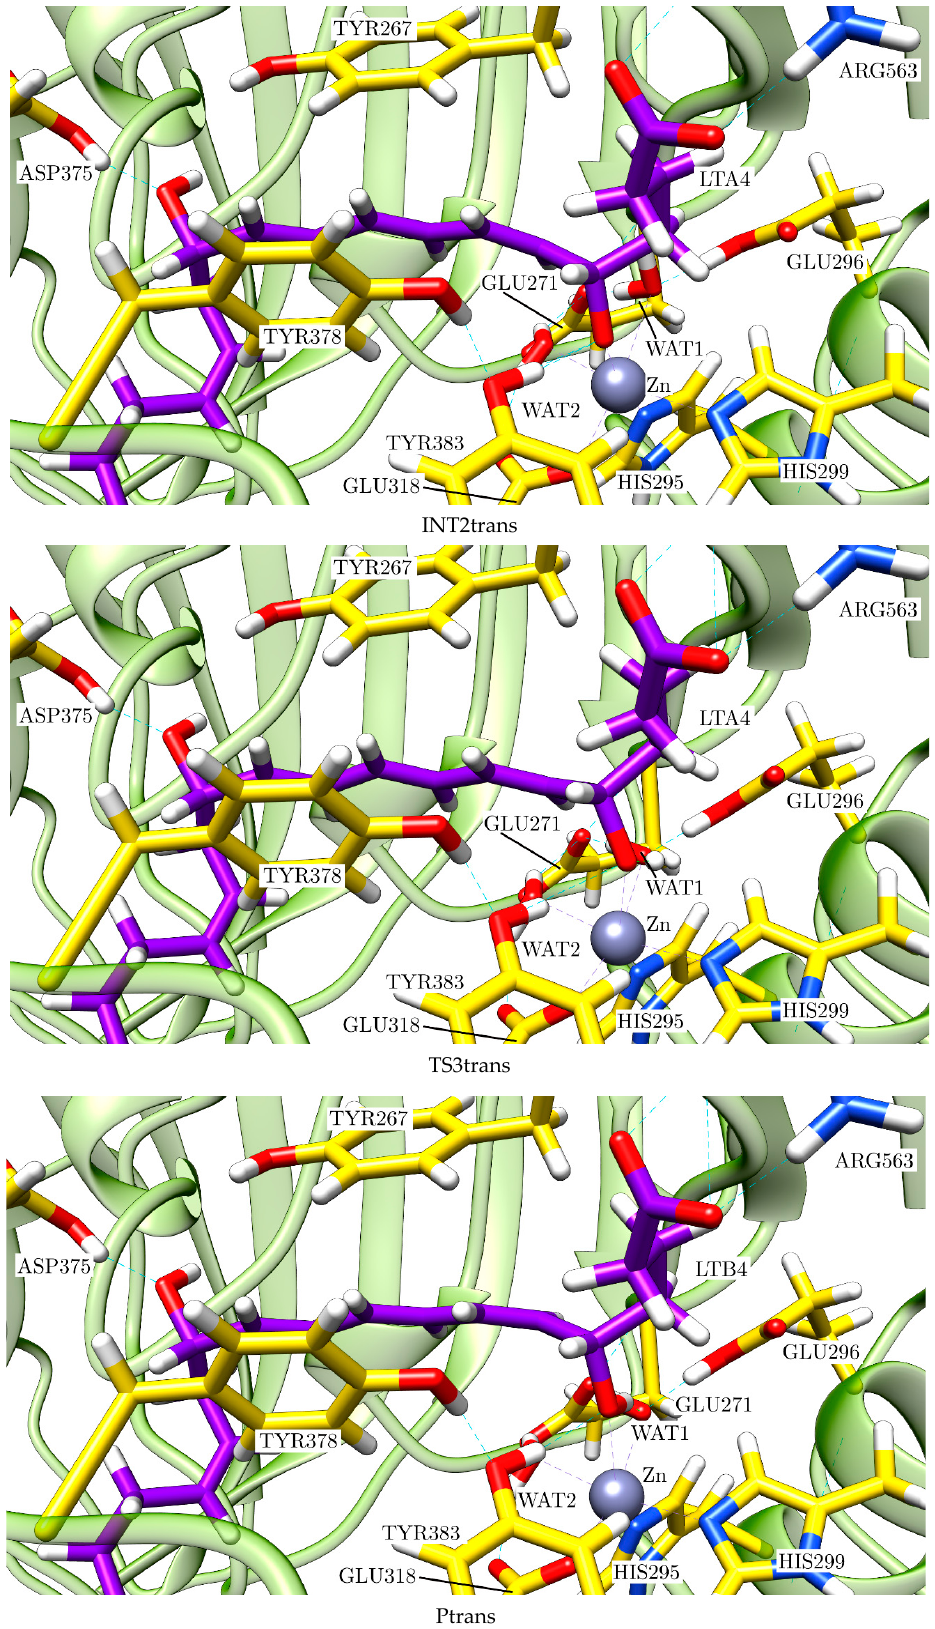
Figure 14. Stationary structures of the complete mechanism of the pro- trans reaction path catalysed by LTA 4 H: TS1trans, INT1trans, TS2trans, INT2trans, TS3trans and Ptrans. The evolution of the main geometrical parameters along the pro- trans reaction path is indicated in Table 2. Analogously to the case of the pro- cis reaction path, in the first step of the pro- trans reaction path, the oxygen of the epoxide is stabilised by the interaction with the Zn atom, the hydroxyl group of TYR383 and the hydrogen bond interaction with WAT2 and WAT1, although WAT1 also moves away at INT1trans. Conversely, the Zn- O epox bond is significantly shortened from 3.39 Å in R to 1.98 Å at INT1trans. The epoxide is fully opened at INT1trans of this S N 1 mechanism. This step implies a potential energy barrier of only 7.9 kcal/mol. The key stereochemical features of the complete reaction are determined in this first step, where the fate of the process is decided. Thus, the dihedral angle H 6 -C 6 -C 7 -H 7 is 196.9° at TS1trans and 183.7° at INT1trans, a clearly trans stereochem- istry. This twist of the triene moiety takes place in the opposite direction to the twist that happens in the pro- cis reaction path. This way, WAT3 now becomes ready to attack the S face of C 12 (by the same side as the Zn atom, see Figure S5) at INT1trans. Then, WAT3 adds to C 12 (the distance O(WAT3)-C 12 evolves from 3.66 Å at INT1trans to 1.51 Å at INT2trans), while one of its hydrogen atoms is fully transferred to ASP375 through the corresponding hydrogen bond. This second step involves a potential energy barrier of 18.7 kcal/mol. Fi- nally, in the third step, the final transfer of a proton from WAT1 to the oxygen atom bonded to C 6 takes place, while the distance Zn-O epox clearly increases through a potential energy barrier of 17.8 kcal/mol, thus forming 12 S -6- trans -LTB 4 , the stereoisomer of LTB 4 . Table 2. Most relevant distances (in Å) and dihedral angle (in degrees) defining the E / Z character of the C 6 -C 7 bond for the stationary structures of the pro- trans reaction path catalysed by LTA 4 H. Pro- trans Reaction Path